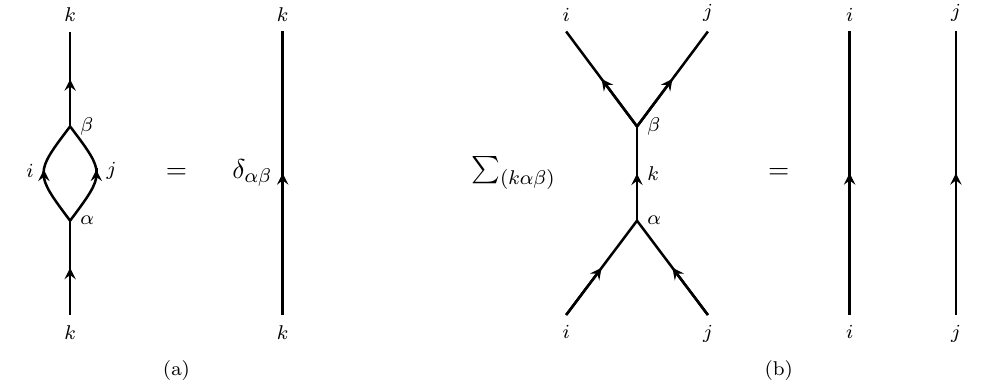
Figure 6 . (a) Graphical representation of the fact that the two basis are dual to each other. (b) Completeness of the basis. Here, sum over ( k(cid:11)(cid:12) ) represents a sum over all such consistent